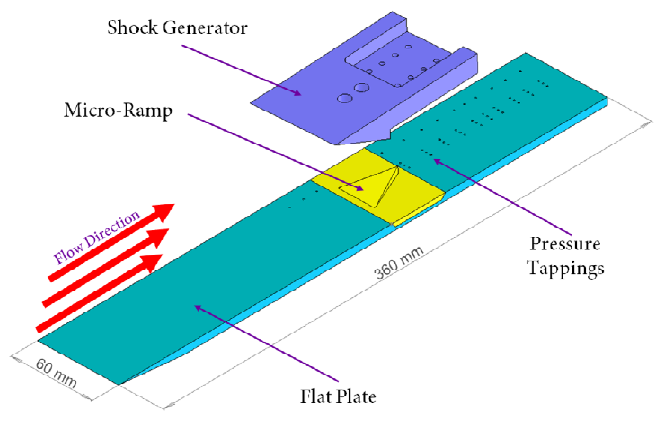
Figure 6. Overall setup including the shock generator.